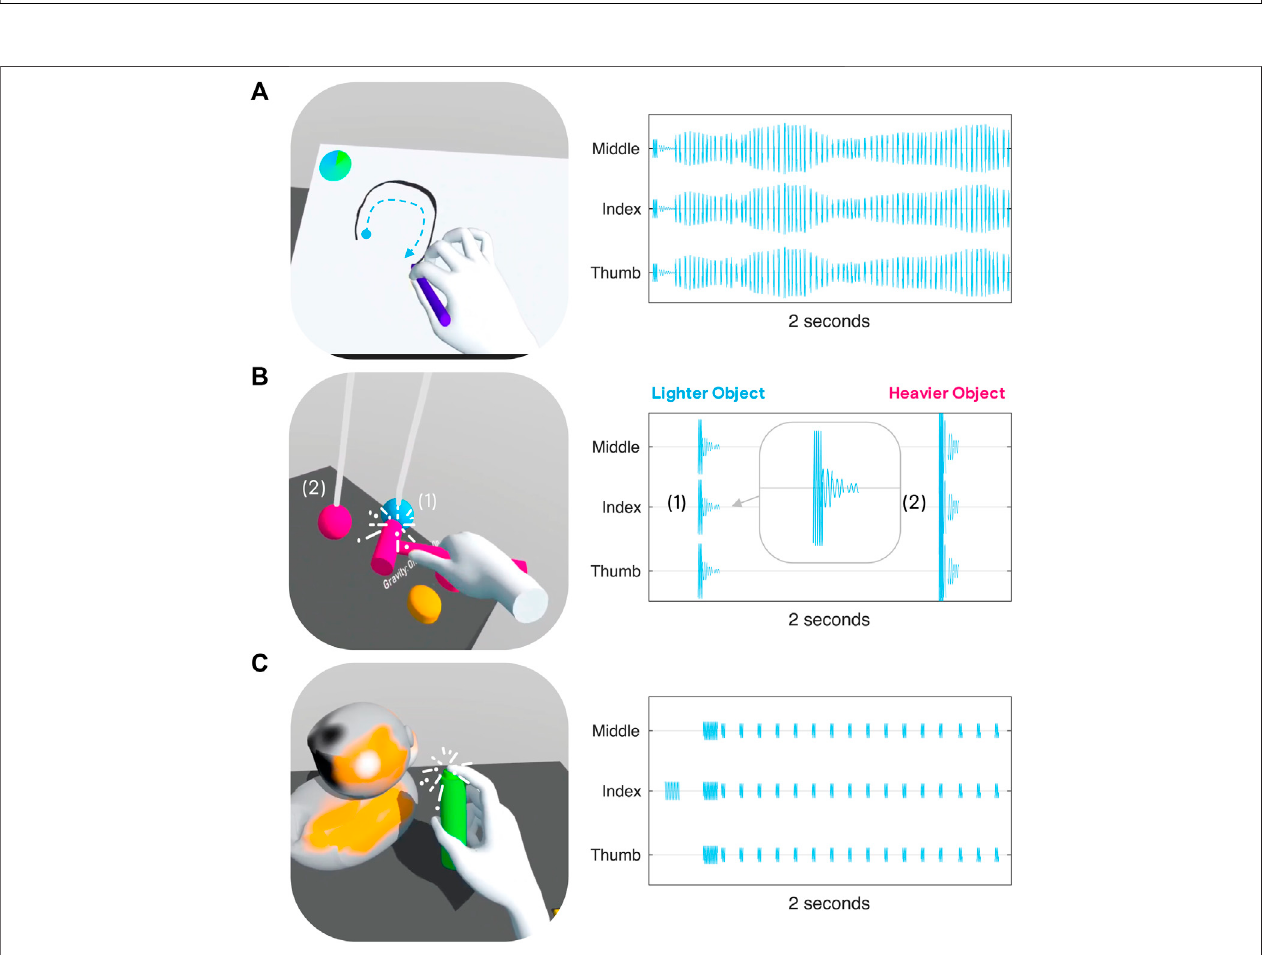
FIGURE 7 | Haptic rendering output, shown as waveforms, during a time window oftool interaction in the following scenarios: (A) when drawing with the pen tool, (B) when striking objects of different weights with the hammer tool, (C) when spraying paint using the spray painting tool.